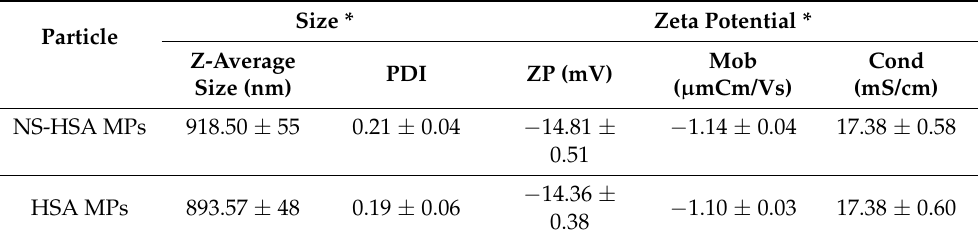
Table 2. Characteristics of hydrodynamic diameter and zeta potential in NS-HSA MPs and HAS-MPs by zetasizer.